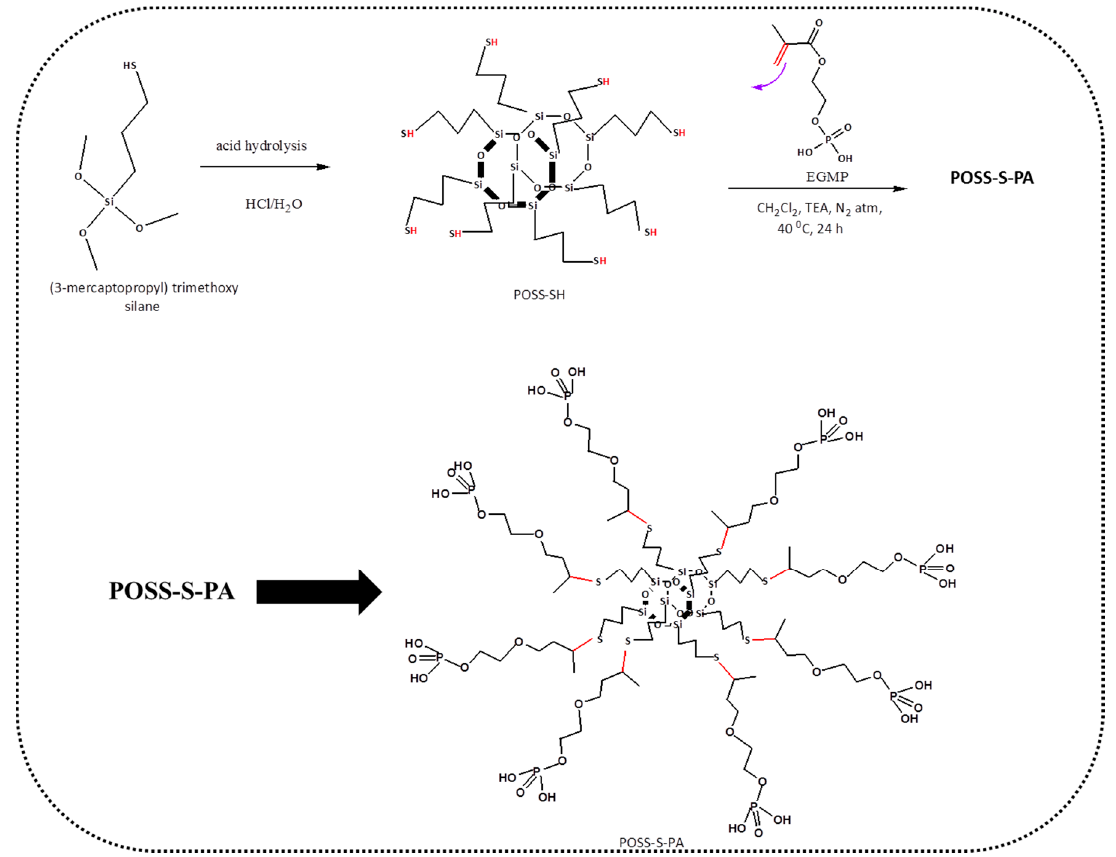
Figure 1. Pictorial representation of thiol-ene click reaction between POSS-SH and EGMP.